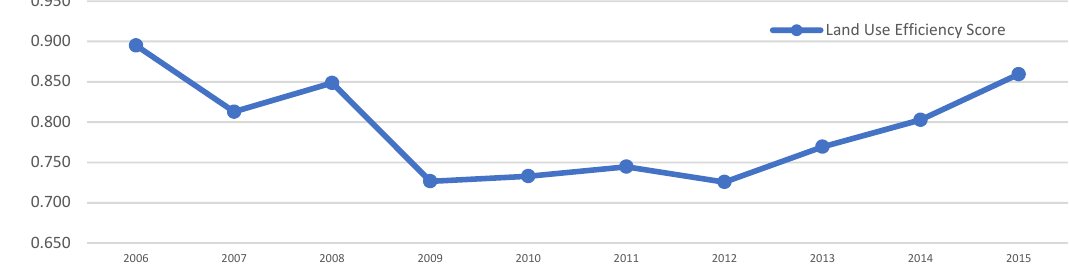
Figure 4. The overall (average) land use efficiency score trend for the total of studied cities in Shanxi Province from 2006–2015.